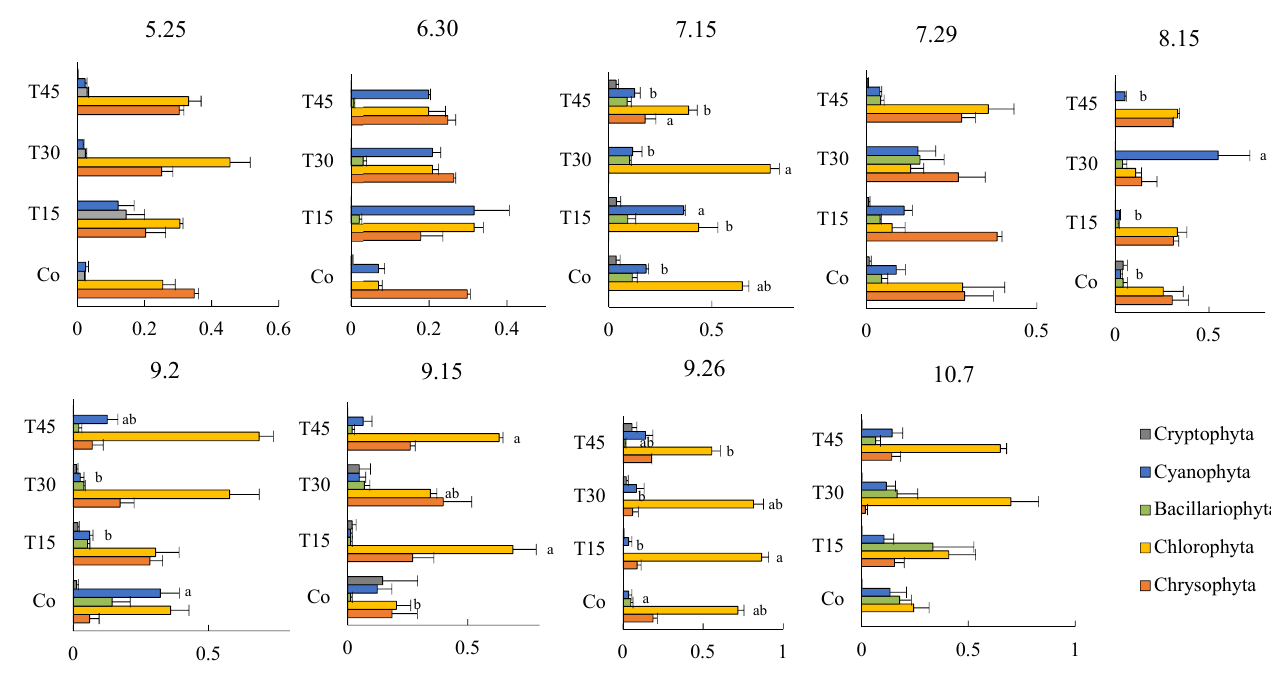
Figure 7. Dominance phytoplankton at phyla level in different treatment groups during the experiment.